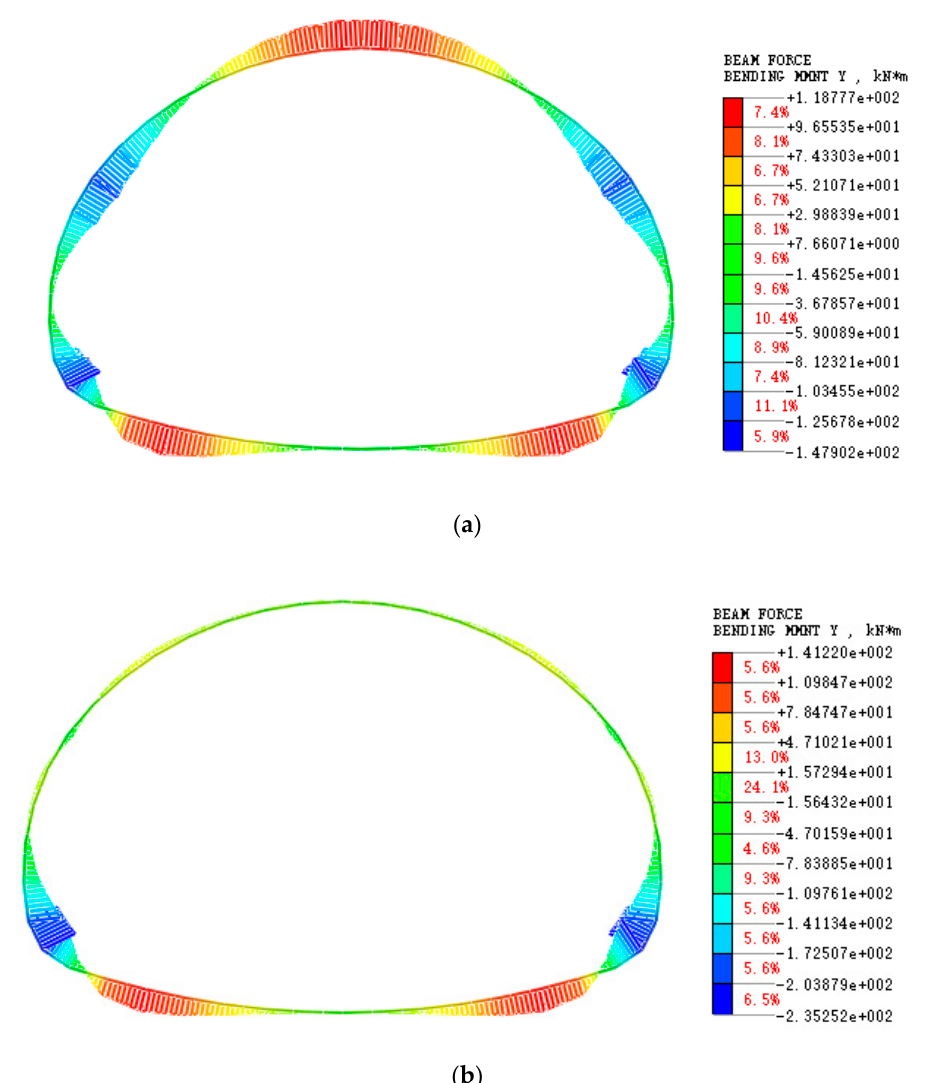
Figure 9. Calculation results of bending moment of tunnel lining before and after load adjustment. ( a ) Bending moment of lining structure before implementation. ( b ) Bending moment of lining structure after the implementation of load adjustment.